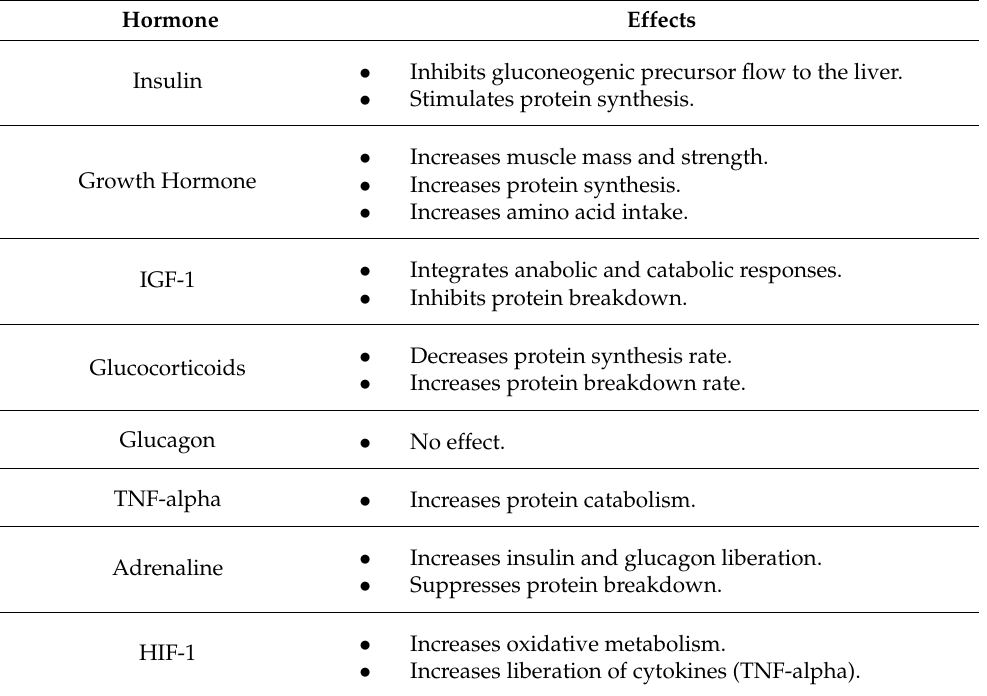
Table 1. Main effects of different hormones in muscle